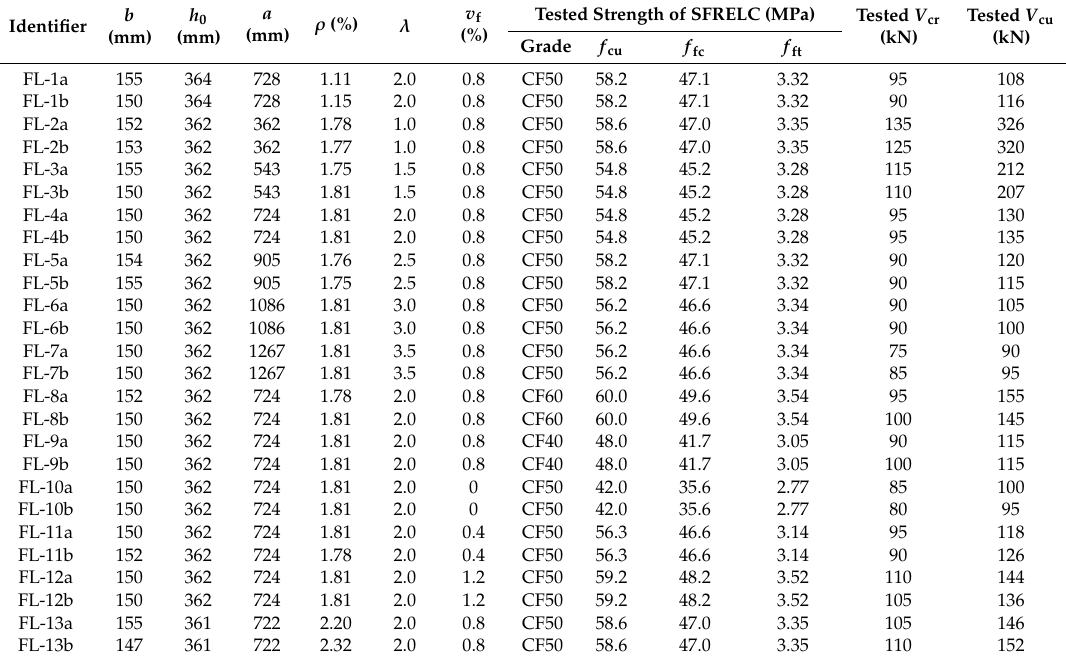
Table 1. Sectional dimension and influencing factor combination of test beams. SFRELC, steel fiber reinforced expanded-shale lightweight